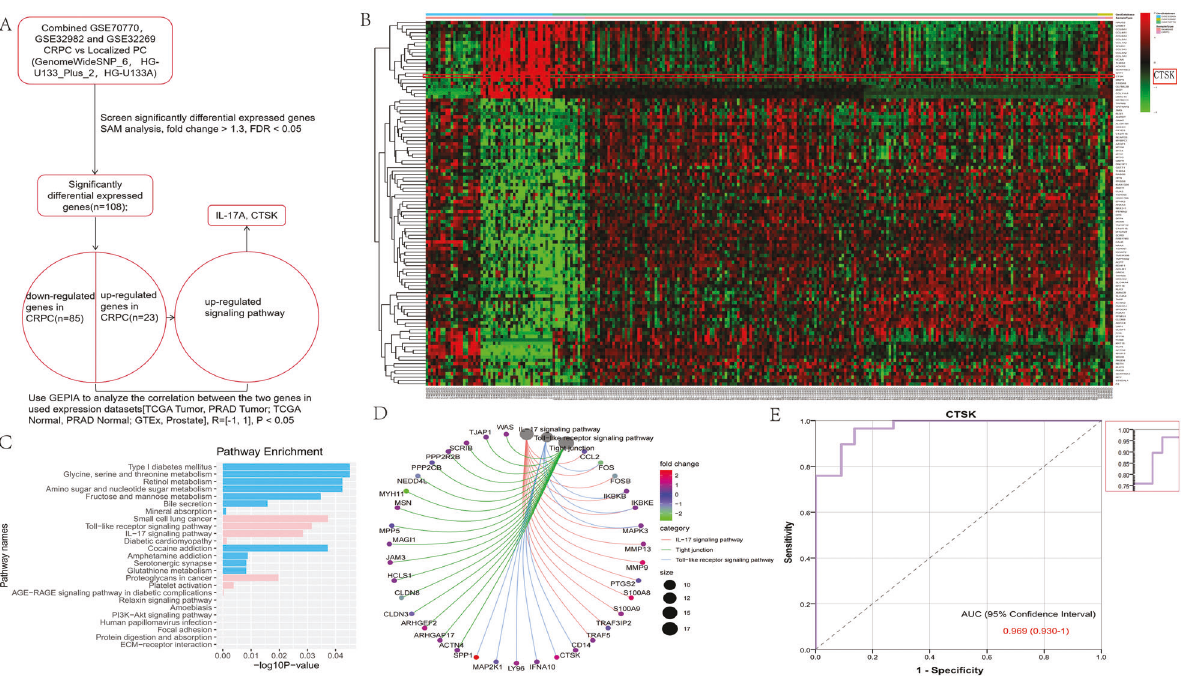
Fig. 1 Over-expression of CTSK-associated IL-17A in castration-resistant prostate cancer. A Principle description of the work procedure used to study the “ IL-17A/CTSK ” axis in CRPC. The expression pro fi les data of various types of prostate cancer (#GSE70770, GSE32982